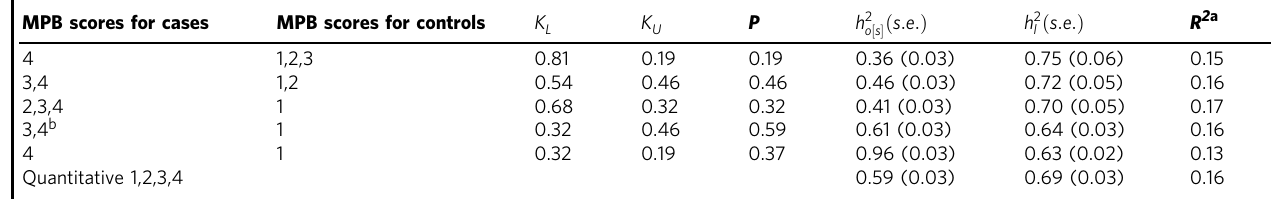
K L proportion of the population in the lower tail, extreme controls. K U proportion of the population in the upper tail, cases. P proportion of the samples used for analyses that are cases. a Proportion of variance in liability explained by the 107-SNP predictor b The sampling strategy conducted by Pirastu et